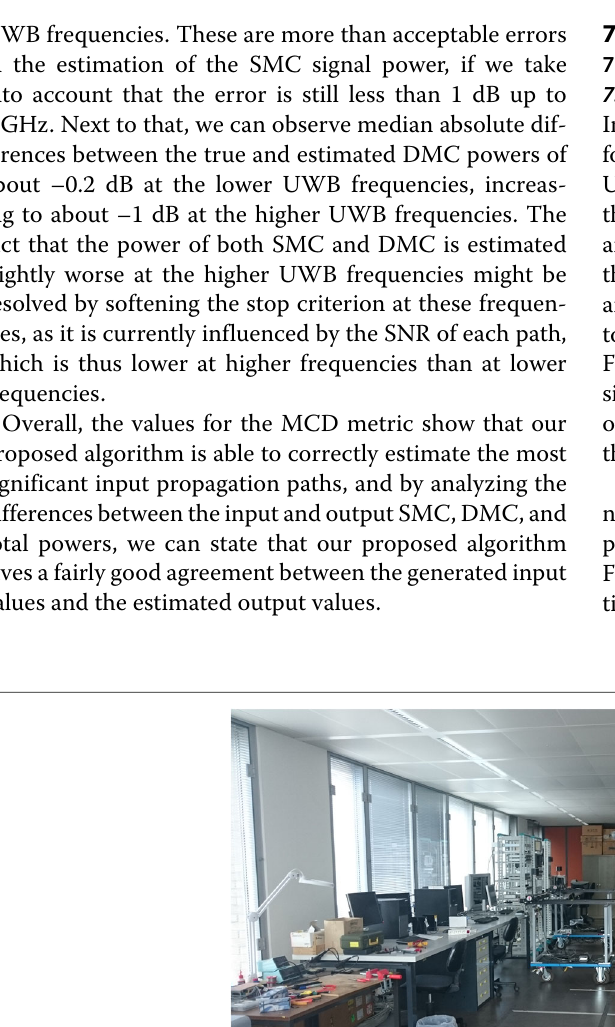
UWB frequencies. These are more than acceptable errors